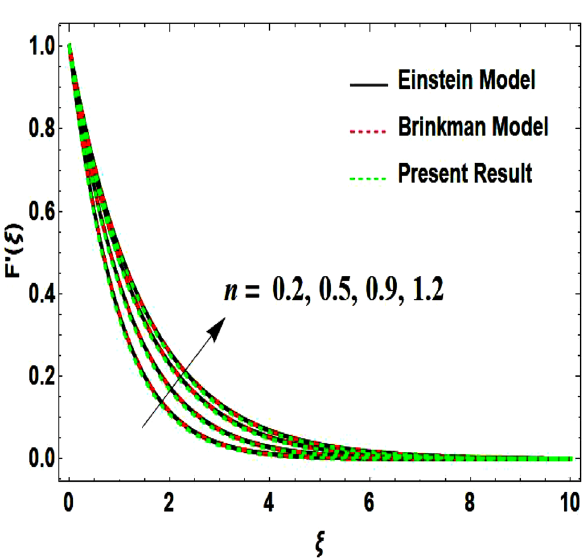
Figure 10. Velocity curve influenced by velocity power index